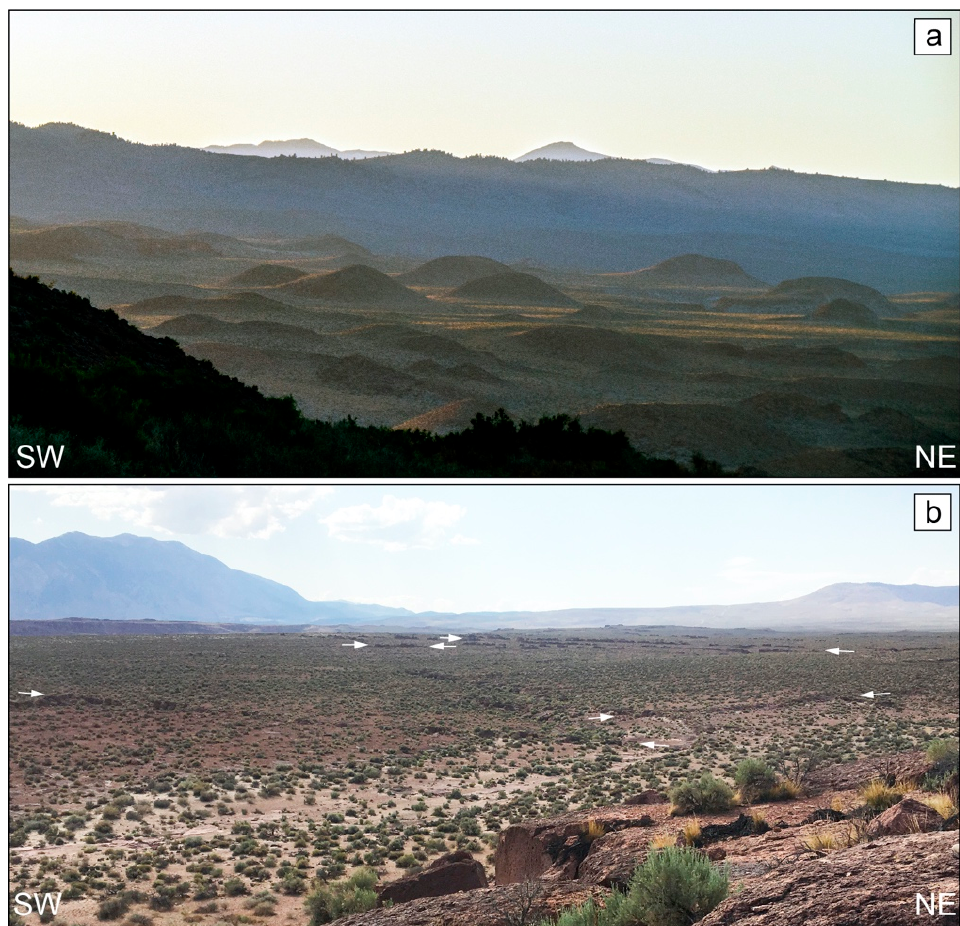
Figure 6. Expression of fumarolic landforms across the Volcanic Tableland. ( a ) Fumarolic mounds of Hammil Valley rising up to 30 m in relief. ( b ) Network of long and narrow fumarolic ridges on the tableland representing relict fumarolic pathways. The ridges are apparent as long dark lines on the photograph. Note white arrows indicating the terminations of some ridges.